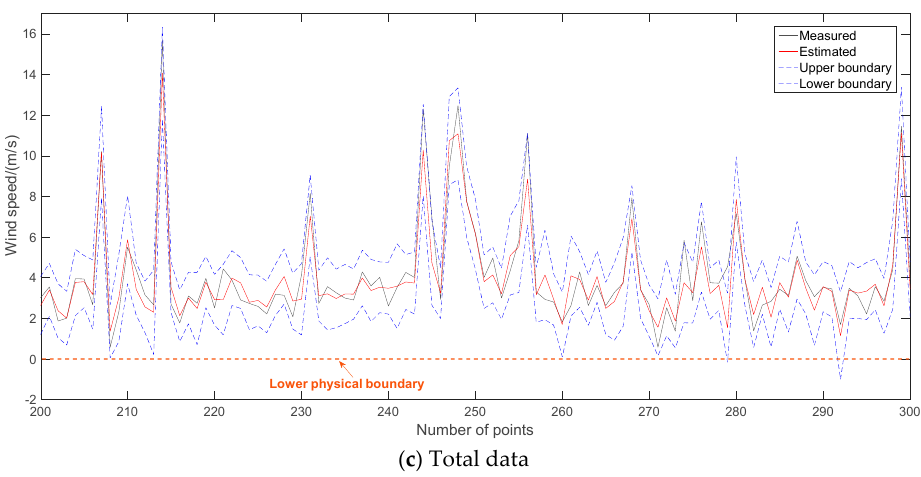
Figure 10. Prediction output of wind speed via GPR models based on different data types.